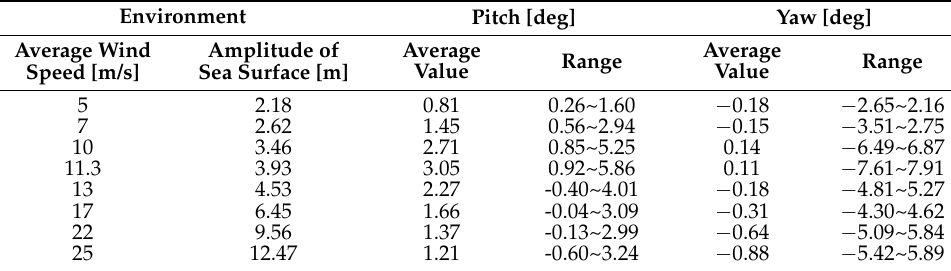
Table 6. FAST simulation results of the pitch and yaw according to the marine environment. Environment Pitch [deg] Average Wind Speed